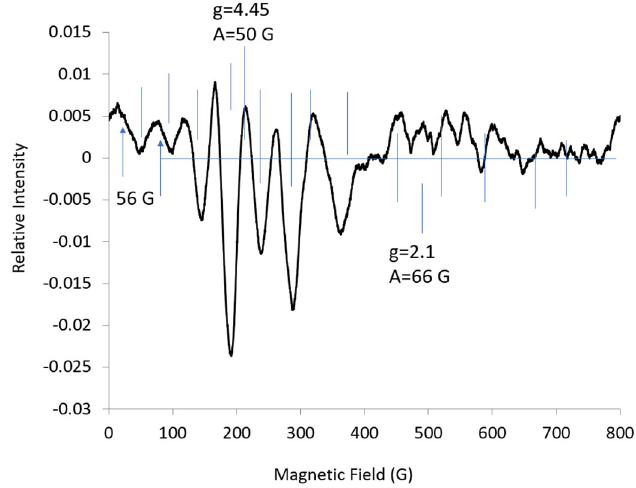
Figure 4. Second harmonic EPR spectrum at L-band (1.37 GHz) for CoEDTA taken from Figure 3, with Bessel function, 4%; temp., 18 K; microwave power, 8 dB; 25 scans averaged. The horizontal line is the baseline. The vertical lines designate g eff values and hyperfine lines. The two lines split by 56 G appear to be attributed to A -max.